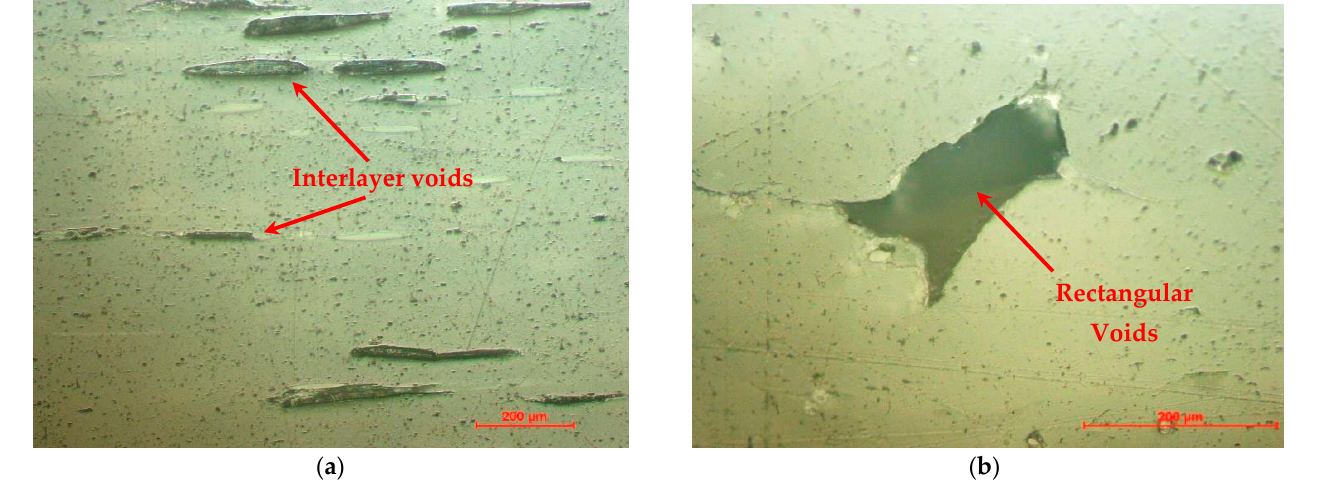
Figure 8. Microscopic analysis of the landing gear made of PLA GF: ( a ) longitudinal section (100×); ( b ) cross-section (100×).